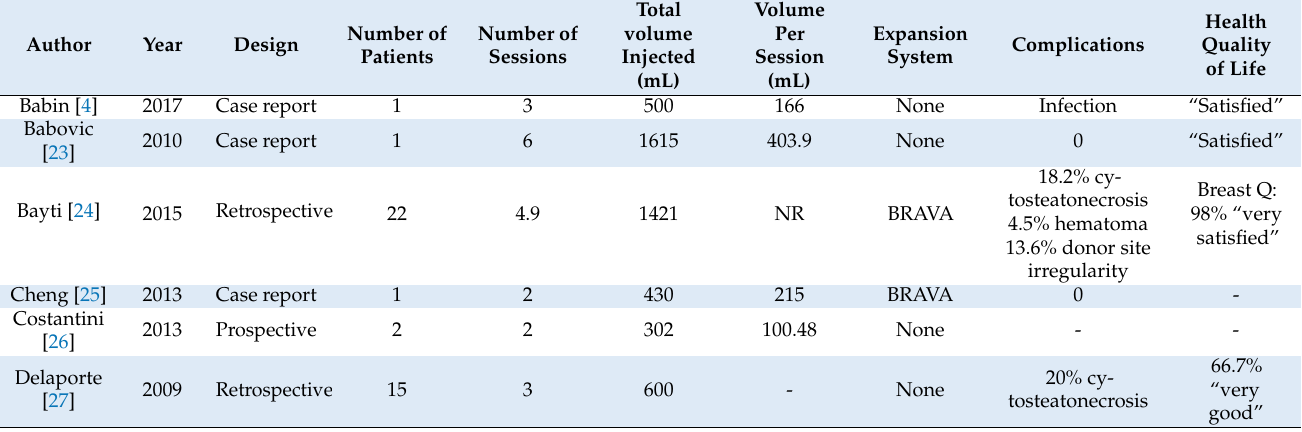
Figure 4. Flow chart of the screening process. Table 4. Characteristics of the included studies.